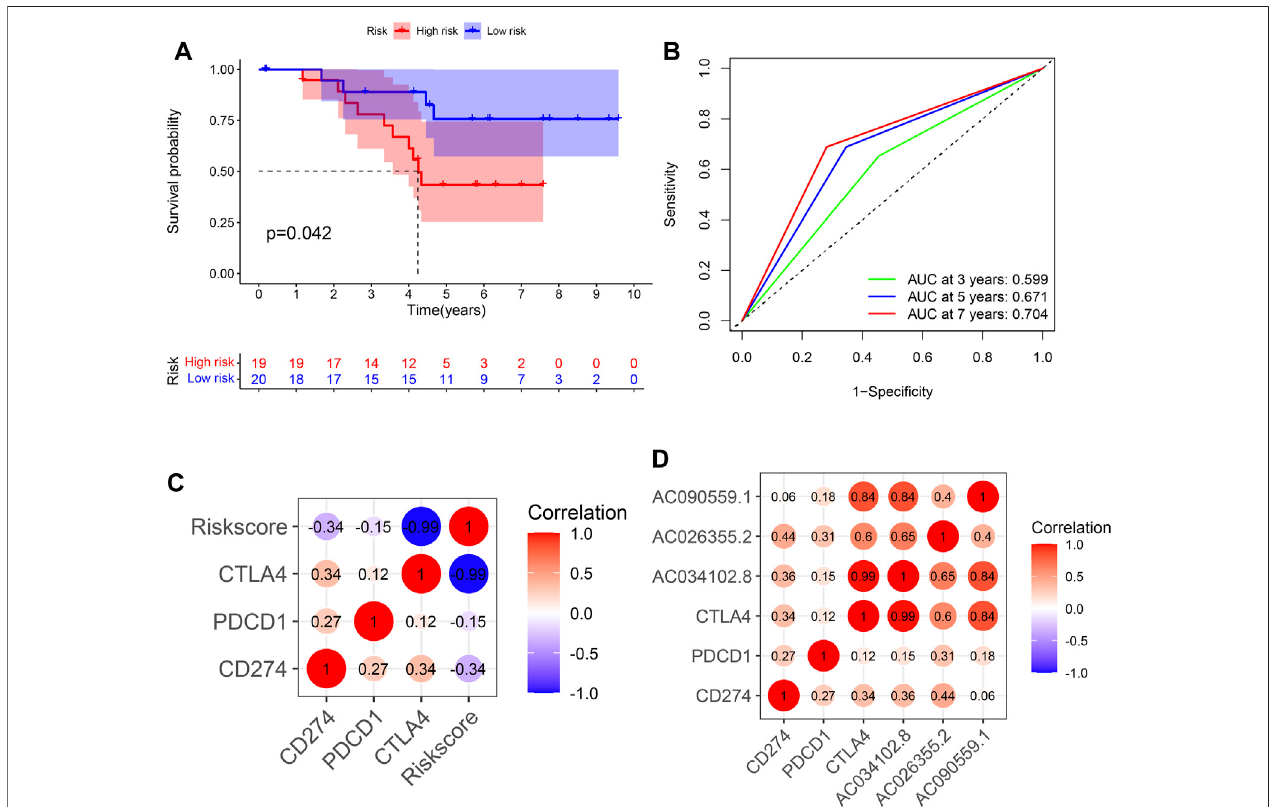
FIGURE 7 | Validation of risk score using clinical specimens of LUAD patients. (A) Kaplan – Meier curve of high- and low-risk groups in clinical LUAD patients. (B) Time-dependent ROC curves of OS at 1, 3, and 5 years. (C) The correlation between 3 identi fi ed lncRNAs, risk score and immune checkpoints. LUAD, lung adenocarcinoma; OS, overall